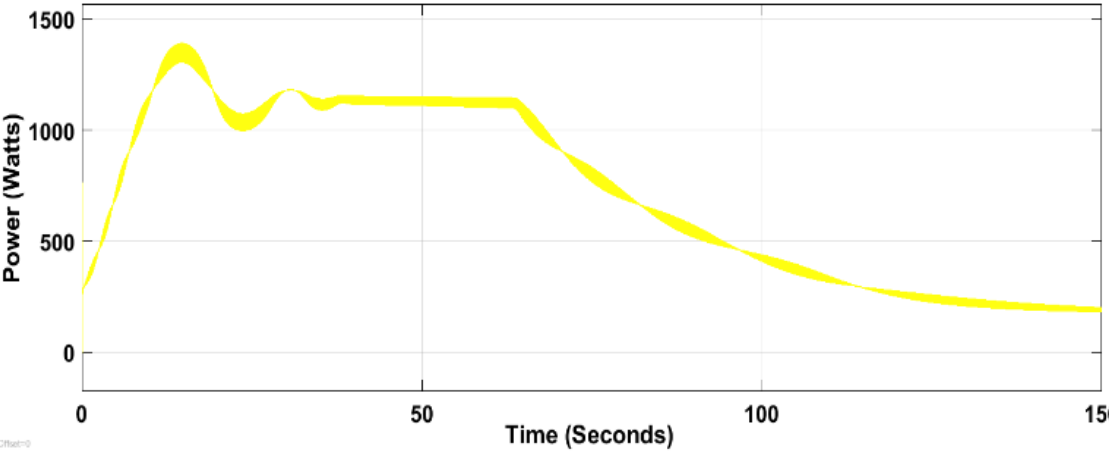
Figure 5. Electric Power Output of the 1 KW PMSG.